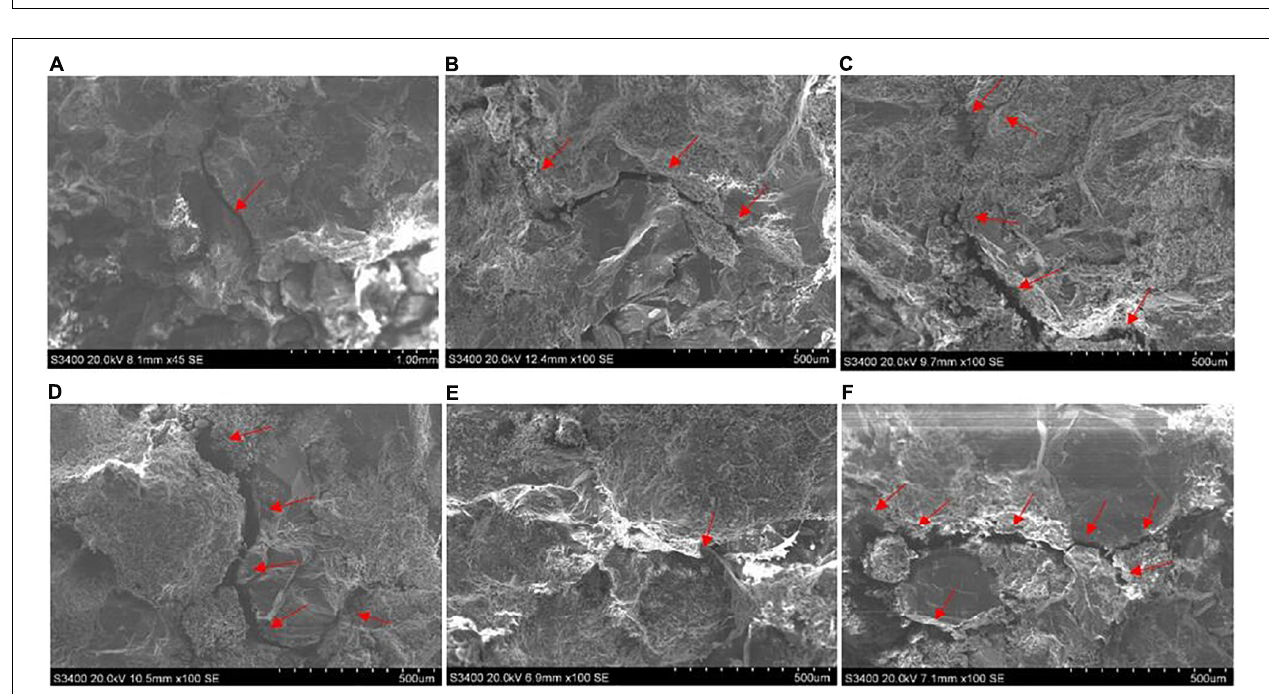
FIGURE 7 | X-ray diffraction of specimen with different treatment conditions: (A) original specimen, (B) specimen 50M1.